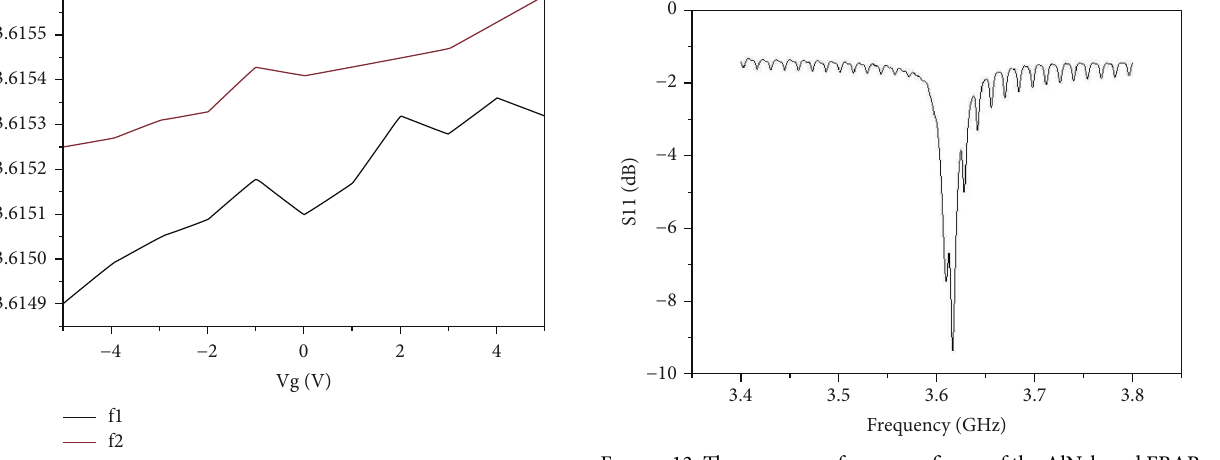
Figure 11: Te fgure for infuence of gate voltage change on the resonance frequency shift value during acetone experiment. Te black curve f 1 stands for the resonance frequency before acetone addition, the red curve f 2 stands for the resonance frequency after acetone addition.